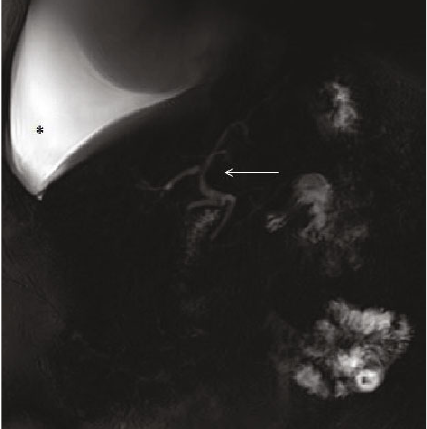
Figure 2: Magnetic resonance cholangiopancreatography. Coronal reconstruction. Normal caliber of bile and pancreatic ducts, no connection with fl uid collections. Massive amount of free fl uid in the right pleural cavity. White arrow: cholangiopancreatic ducts. ∗ Free fl uid in pleural cavity.